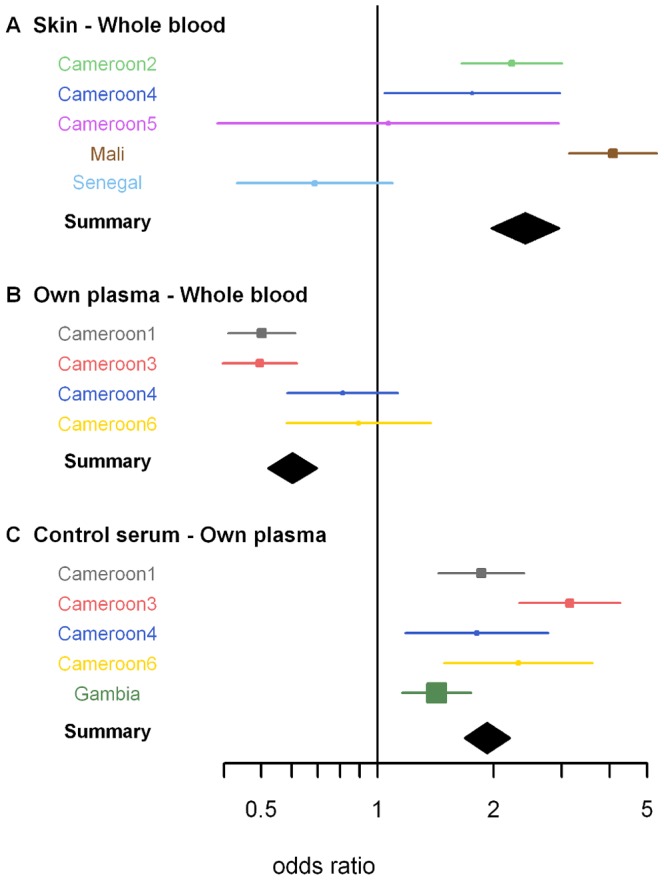
A forest plot showing the overall result of each study together with the overall estimates of the meta-analysis.All data were combined to generate the summary odds ratio and 95% confidence interval estimates denoted by the black diamond. Odds ratios are calculated with the latter feeding condition as reference; e.g. for Figure 2A the odds ratio for mosquito infection in skin feeding experiments is calculated with whole blood membrane feeding as reference. Points are weighted according to the number of paired experiments in the study (indicated by the size of the data point).